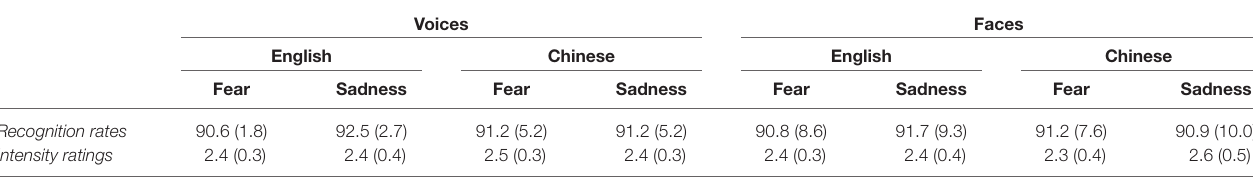
TABLE 1 | Mean recognition rates (percent correct target identification) and emotional intensity ratings of the vocal and facial stimuli by emotion and cultural group (standard deviation in parentheses) .